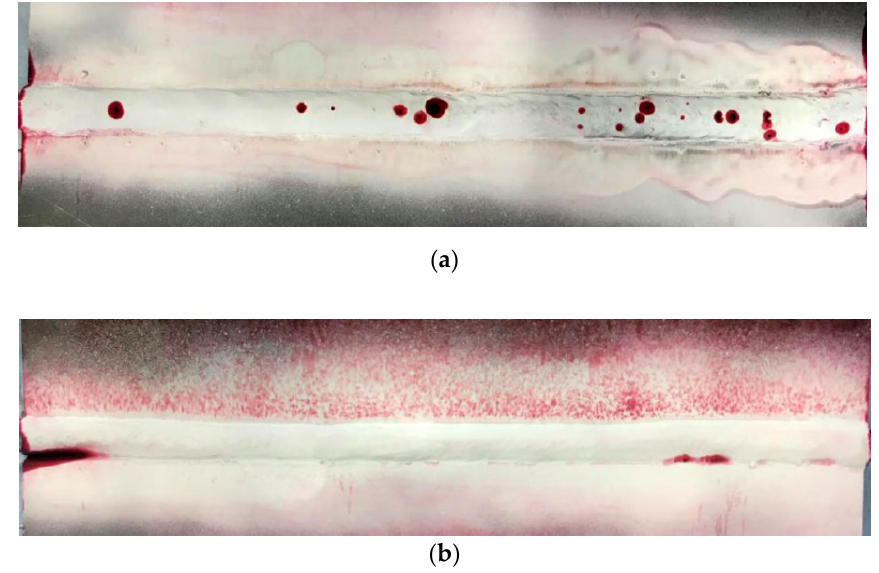
Figure 6. View of specimens after PT: ( a ) specimen SW and ( b ) Specimen SA.